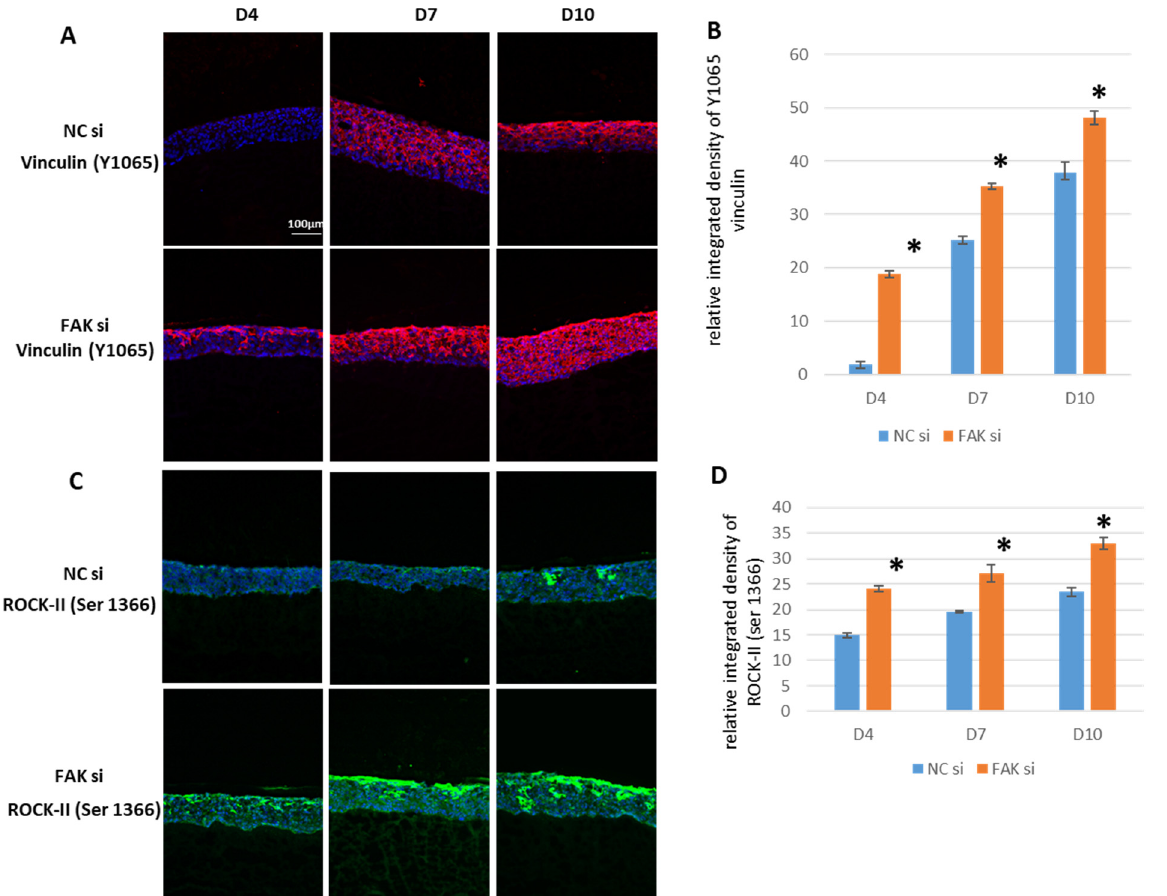
Figure 6. siRNA-mediated inhibition of FAK in GK-based cocultures and the influence on vimentin and cytokeratin 19 (K19) expression and distribution. Cells were transfected with FAK-siRNA and incubated for 48 h before usage in the coculture setup for a further 4, 7, or 10 days. Shown in ( A ) are representative IIF images of cryofixed sections of FAK-siRNA-treated versus nontreated cocultures, stained with an anti-vimentin antibody. In ( C ), epithelial equivalents are stained with an anti-cytokeratin 19 antibody after the indicated periods of time. The bar graph in ( B ) shows the SQFI by measuring the relative integrated fluorescence density of the vimentin fluorescence signal. Likewise, ( D ) represents the same analysis for the cytokeratin 19 fluorescence signal and compares the FAK-siRNA-inhibited cocultures with the noninhibited controls. ( n = 3 for all experiments, values are depicted as mean +/ − SEM; * = p < 0.05. Scale bars represent 100 µm. NC = negative control; D = day).